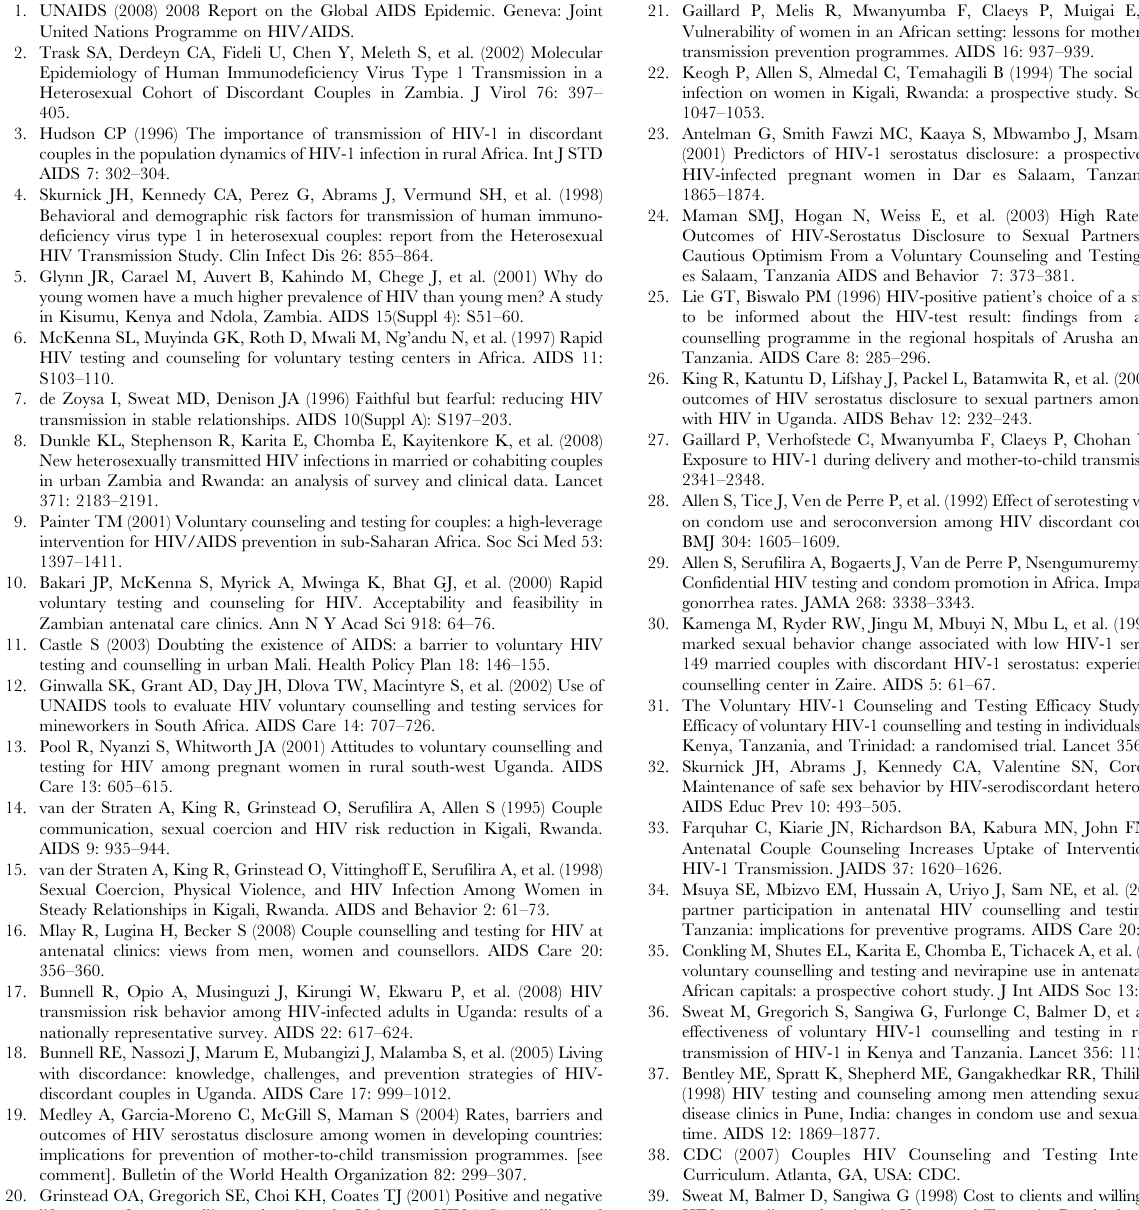
Table S3 Knowledge and Perceptions of Couples’ VCT a by Cohabitation, Education, and Gender among Lusaka